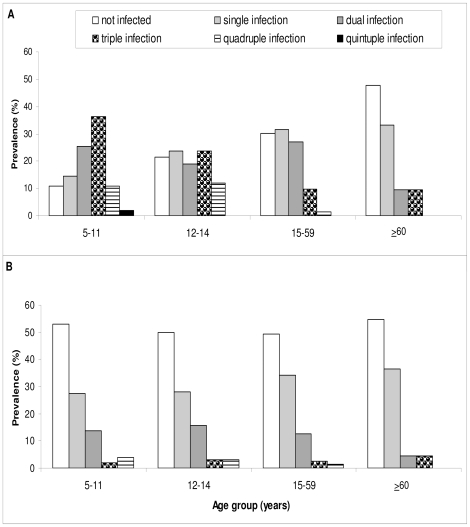
Polyparasitism in rural Bandamaji and peri-urban Dole, Zanzibar, in June/July 2008.Bar chart indicating the number of infecting helminths (polyparasitism of soil-transmitted helminths plus S. haematobium) in four age groups of (A) rural Bandamaji and (B) peri-urban Dole. (A) age group 5–11 years: n = 55; age group 12–14 years: n = 42; age group 15–59 years: n = 152; age-group ≥60 years: n = 21. (B) age group 5–11 years: n = 51; age group 12–14 years: n = 32; age group 15–59 years: n = 79; age-group ≥60 years: n = 22.